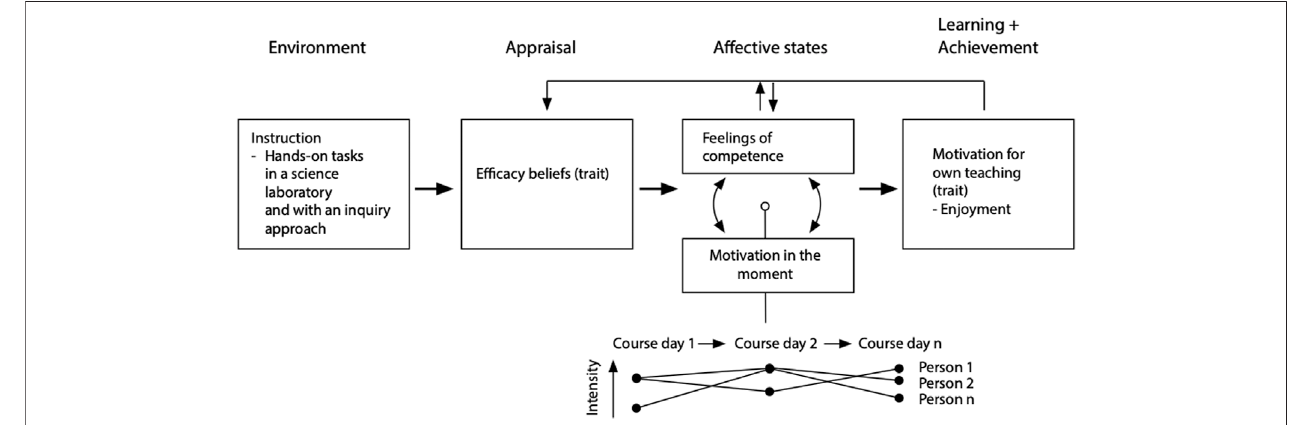
FIGURE 1 | Research model derived from Pekrun ’ s control-value model